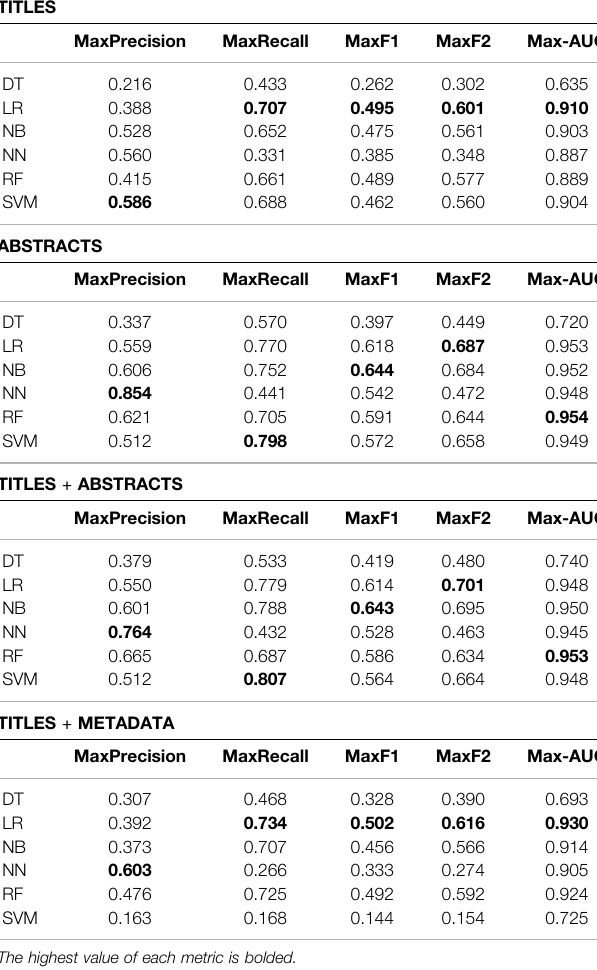
TABLE 2 | Dietary biomarkers document classi fi cation results. Highest precision, recall, F1-score, F2-score and AUC achieved by each algorithm: Decision Tree (DT), Logistic Regression (LR), Naïve Bayes (NB), Neural Network (NN), Random Forest (RF) and Support Vector Machine (SVM). The highest value of each metric on each feature type is